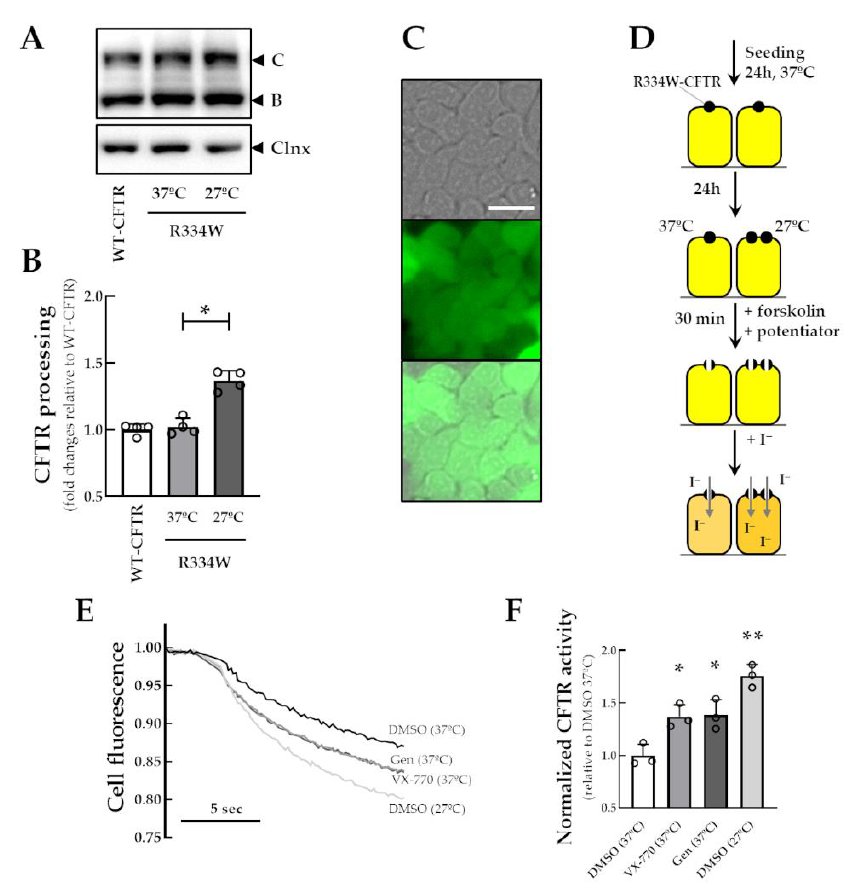
Figure 1. Characterization of a new cell line co-expressing the HS-YFP and R334W-CFTR. ( A ) Representative WB images of CFBE cells expressing WT- and R334W-CFTR incubated for 24 h at 37ºC or 27ºC. ( B ) CFTR processing [band C / bands B+C] was quantified and normalized to calnexin (Clnx) levels (loading control). Data are represented as means + SD: *P < 0.05 vs. R334W 37ºC. ( C ) R334W-CFTR-expressing CFBE cells demonstrating cytosolic fluorescence of the HS-YFP (F46L/H148Q/I152L). Scale bar: 50 µm. ( D ) Schematic flow of the HS-YFP assay. CFBE cells co-ex- pressing R334W-CFTR and the HS-YFP were incubated for 24 h at 37ºC or 27ºC and then acutely stimulated (30 min) with Fsk (5 µM) plus DMSO (negative control), VX-770 (1 µM) or Gen (50 µM). ( E ) Representative cell fluorescence recording on a plate reader. ( F ) CFTR function was assessed based on the cell fluorescence quenching rate and normalized to the negative control. Data are rep- resented as means + SD: *P < 0.05 and **P < 0.01 vs. DMSO (37ºC).